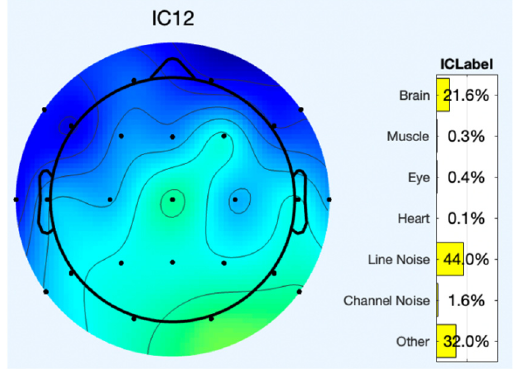
the presence of EEG signals and artifacts in the other components are shown in Table 1. Table 1.